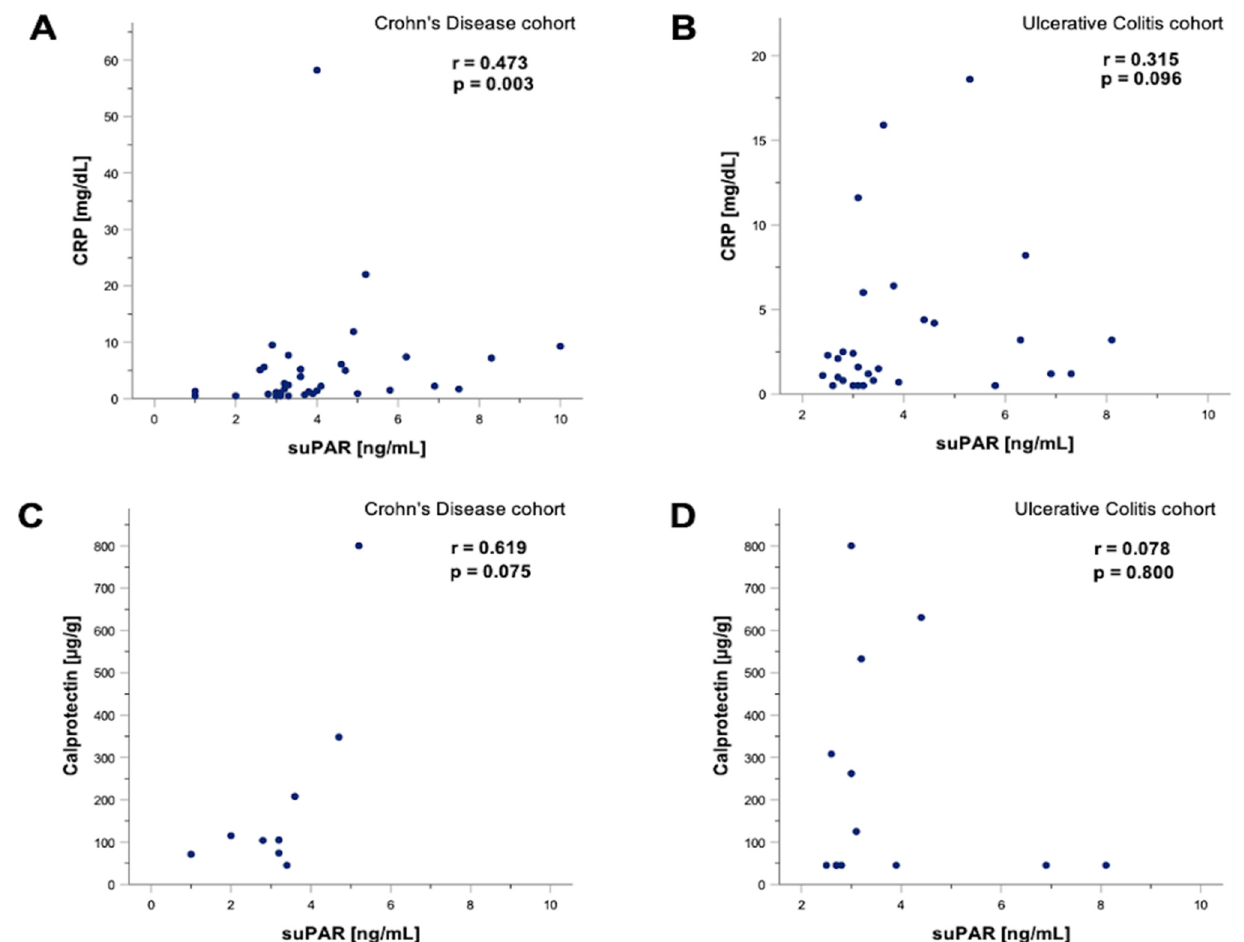
Figure 5. suPAR levels correlate with CRP levels in patients with CD. Soluble urokinase-type plasminogen activator receptor (suPAR) levels correlated with C-reactive protein (CRP) in patients with Crohn’s disease (CD). Spearman rank correlation revealed a positive correlation between suPAR and CRP levels in patients with CD ( p = 0.003; r = 0.473), but not in patients with ulcerative colitis (UC) ( p = 0.096; r = 0.315) ( A , B ). Spearman rank correlation of suPAR and fecal calprotectin levels in patients with UC demonstrated no significant association; however, a tendency towards a significant positive correlation could be detected ( p = 0.075; r = 0.619). In contrast, suPAR levels appeared to be independent of fecal calprotectin levels in patients with CD ( p = 0.075; r = 0.619) and CU ( p = 0.8; r = 0.078) ( C , D ). Soluble urokinase-type plasminogen activator receptor (suPAR). Gastrointestinal (GI). Colitis ulcerosa (CU). Crohn’s disease (CD). C-reactive protein (CRP).